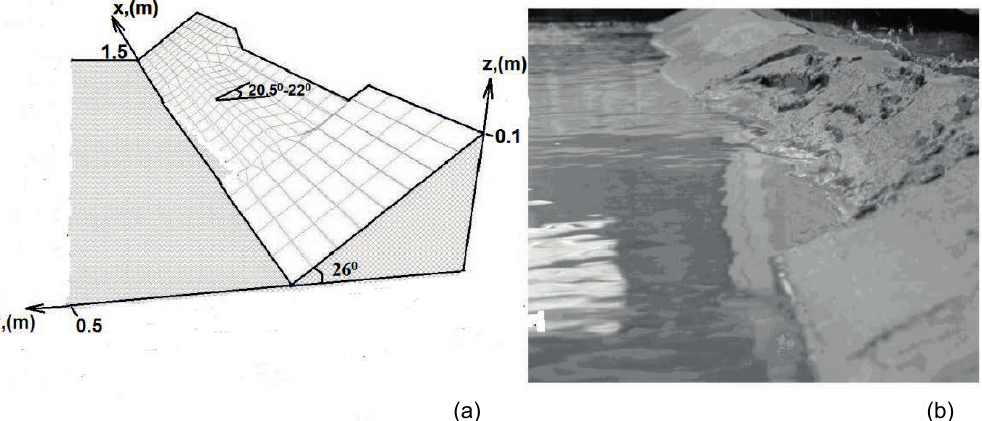
Fig. 2 The topography of the bank at 60 minutes of the simulation time after the start of the numerical experiment (a), a picture of a slope after a laboratory experiment with the same parameters